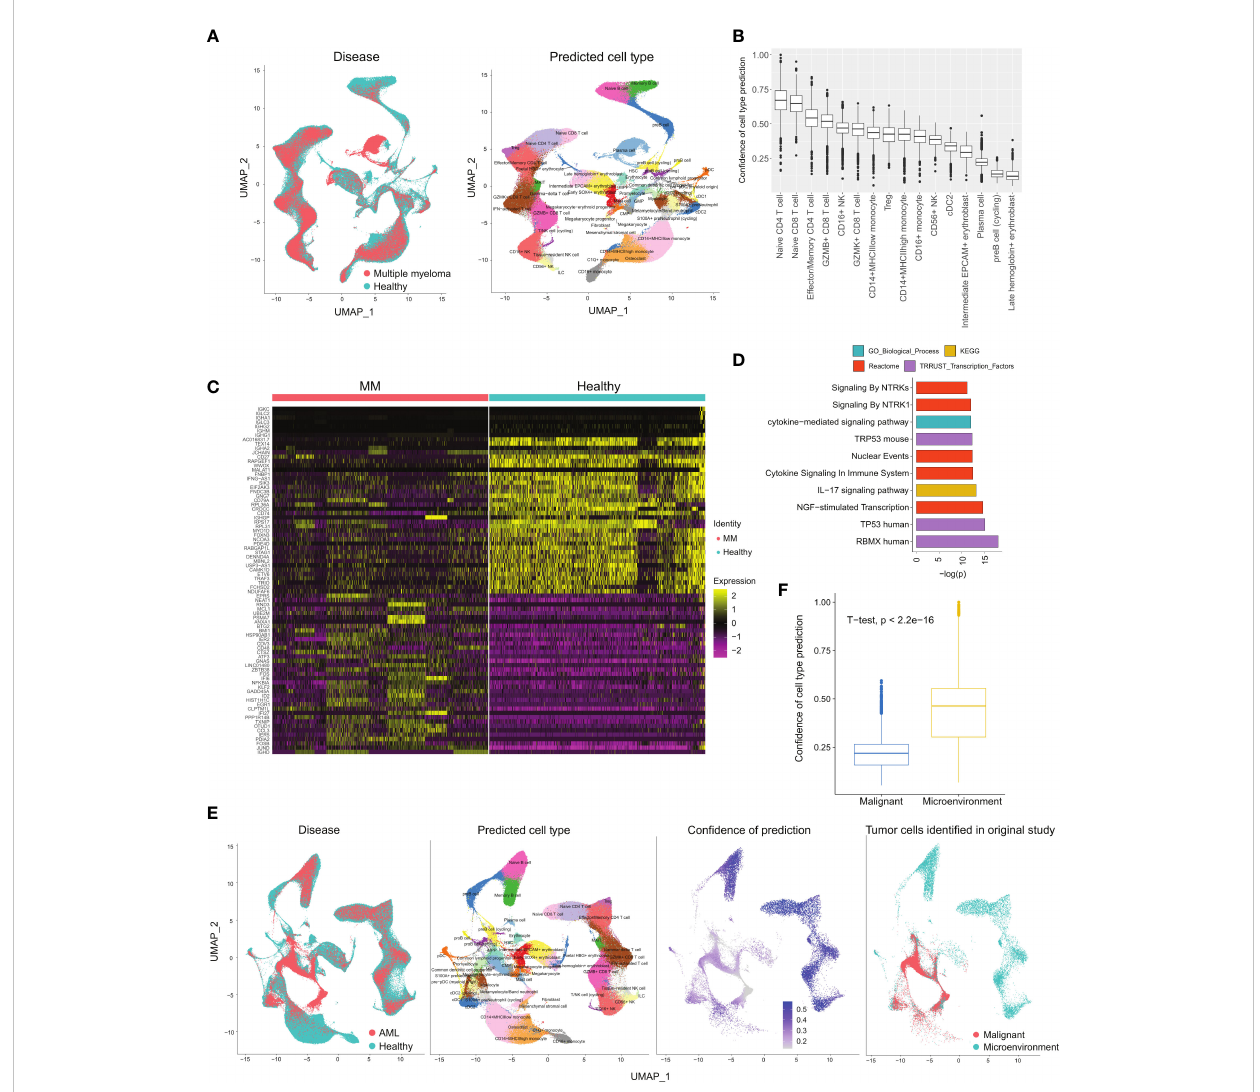
FIGURE 5 Projecting diseased BM samples onto healthy reference to identify disease-speci fi c cells. (A) Multiple myeloma datasets projected onto the healthy BM atlas. (B) Con fi dence scores of cell type prediction of MM samples. (C) Heatmap of DEGs between plasma cells from MM samples versus healthy samples. (D) Pathway enrichment analysis of MM plasma cell DEGs. (E) Projection of AML datasets onto the healthy BM atlas. (F) Con fi dence scores of cell type prediction with AML